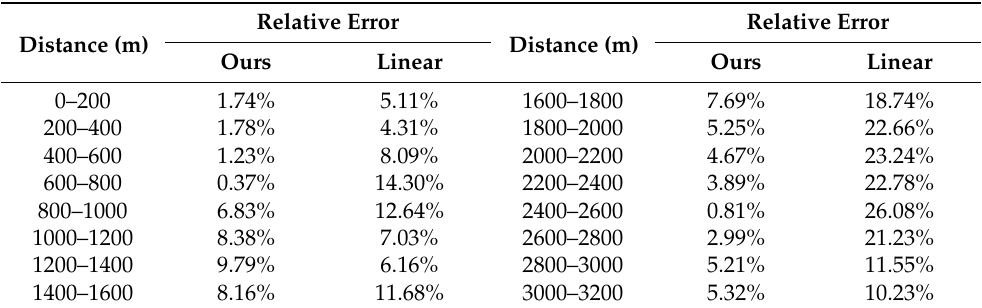
Figure 11. Detailed comparison of the simulated results near the LRT line. ( a ) Classic linear model, ( b ) the proposed model. Table 6. The relative error rates between the actual and simulated urban LU results in 2005 for different rings.